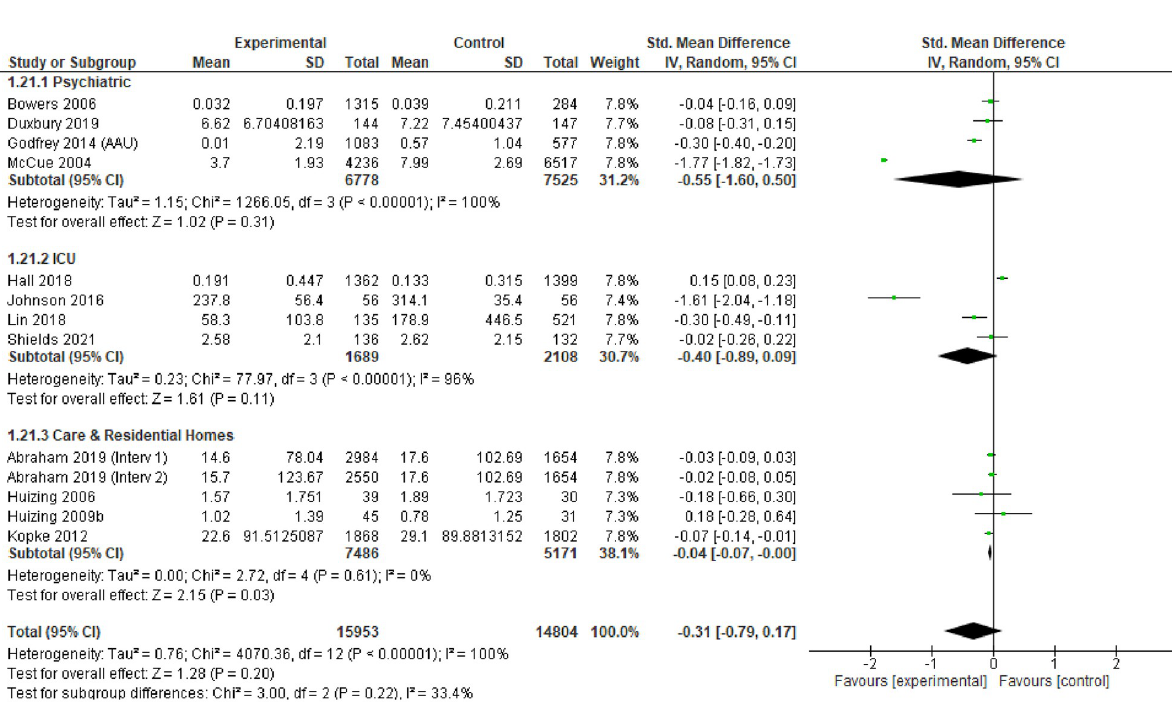
PLOS Global PublicHealth | https://doi.org/10.1371/journal.pgph.0001594 April 24, 2023 21 /